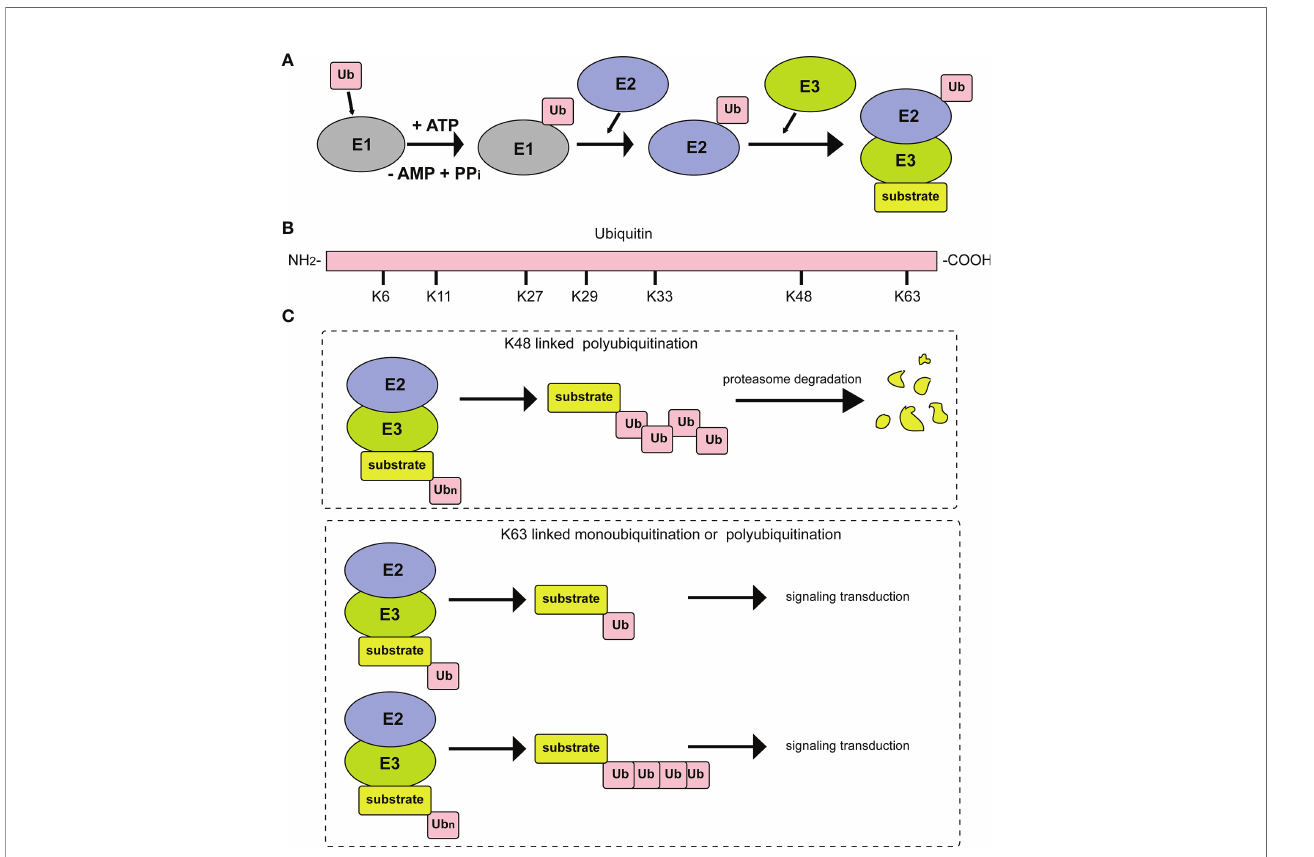
FIGURE 1 | Diagrammatic sketch of the ubiquitin cascade and E3 classi fi cation. (A) Illustration of the ubiquitin/26S proteome pathway. E1 is activated through ATP hydrolysis and adenosylates the ubiquitin molecule. Then, ubiquitin is successfully transferred to E3 from E1 by the catalysis of E2. With the participation of E3, substrates are modi fi ed by the ubiquitin molecule in different linkage modes. (B) The seven lysine residues on the ubiquitin molecule that can be ubiquitinated. (C) Different ubiquitin molecule linkage types. Upper panel, ubiquitin molecules connect with each other through K48 to form a polyubiquitin chain. Substrates modi fi ed by the polyubiquitin chain are degraded by the proteasome pathway. Lower panel, substrate modi fi cation by ubiquitin molecules through K63 type monoubiquitylation or polyubiquitylation, which plays important roles in signal